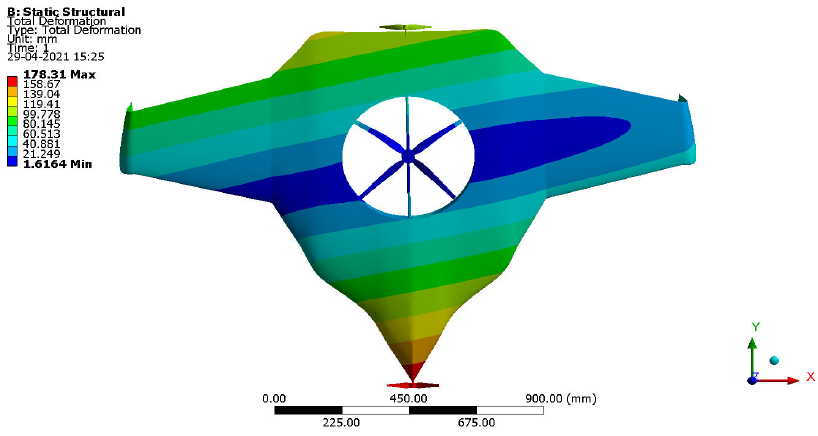
Figure 11. Equivalent stress.